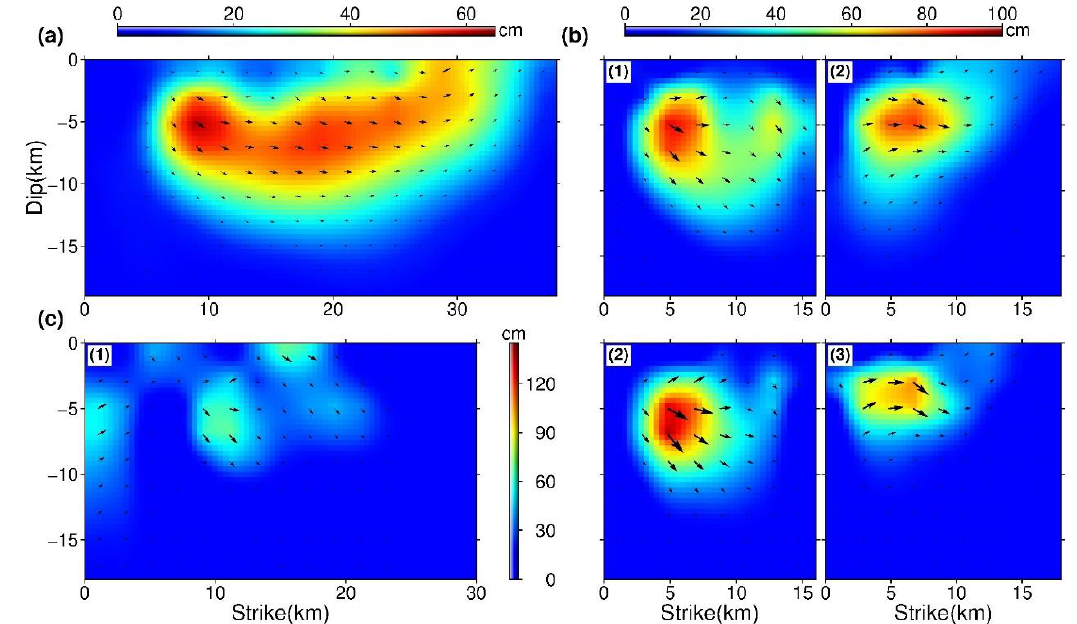
Figure 4. Slip distribution with arrows delineating the average rake of each sub-fault for the three test models, whose magnitude is color-coded. ( a ) Slip distribution for the optimal one-fault model. ( b ) Slip distribution for the optimal two-fault model, including the (1) northern fault and (2) southern fault. ( c ) Slip distribution for the optimal three-fault model, including the (1) secondary fault, (2) northern fault, and (3) southern fault.